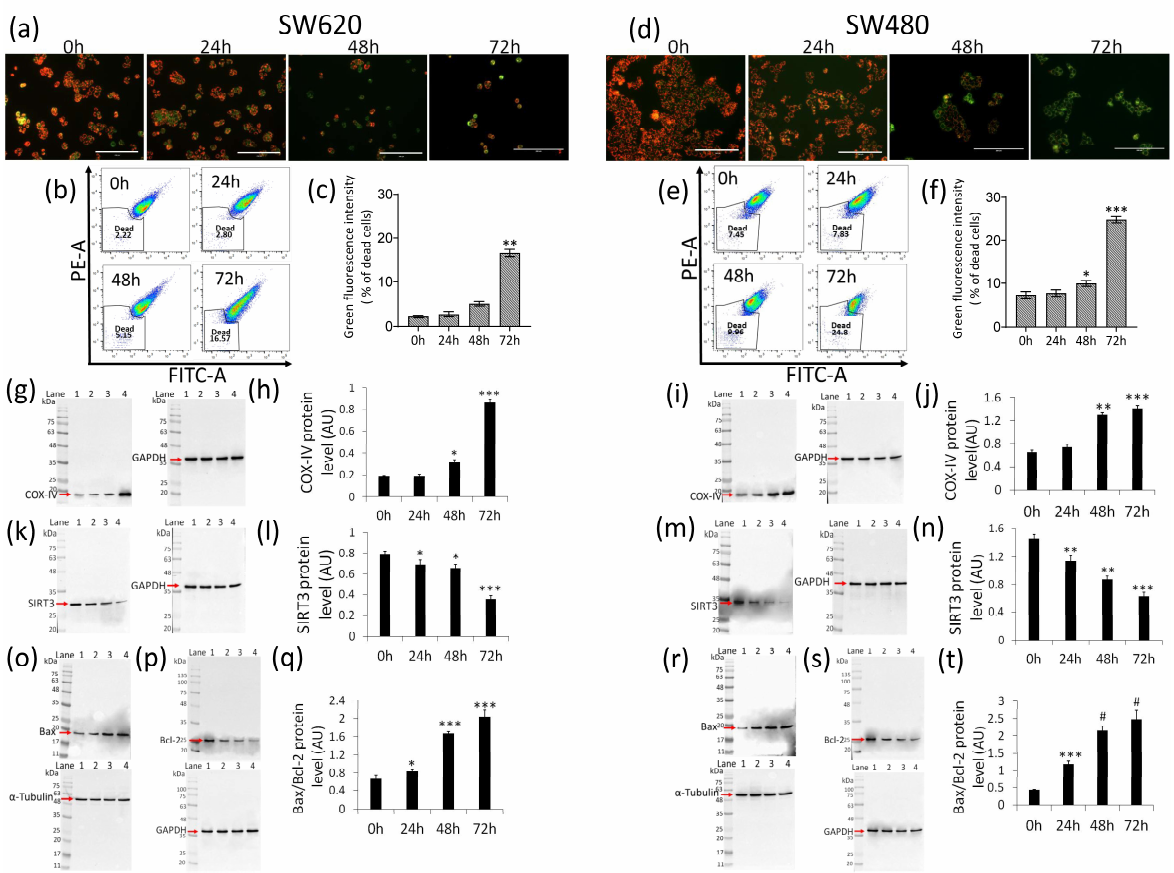
Figure 4. δVB effects on mitochondrial status. Representative images, dot plots and analysis of mitochondrial membrane potential assessed using JC-1 probe, which allows us to detect membrane depolarization through a concomitant decrease in the aggregate signal (red) and accumulation of monomeric species (green), of ( a – c ) SW620 and ( d – f ) SW480 cells. Cells were treated with δVB (1.5 mM) for 24, 48 and 72 h. Results, expressed as green fluorescence intensity, were reported as % of dead cells. Scale bar: 200 μm. Representative immunoblotting images and analyses of ( g – j ) COX-IV, ( k – n ) SIRT3 and ( o – t ) Bax/Bcl-2 protein levels in SW620 and SW480 cells. Lane 1 = 0 h; lane 2 = 24 h; lane 3 = 48 h; lane 4 = 72 h. Before lane 1, molecular weight markers (G266, Applied Biological Materials Inc., Richmond, BC, Canada). Protein expression was calculated, after normalization with internal control (α-tubulin or GAPDH), with ImageJ software and results expressed as arbitrary units (AU). * p < 0.05 vs. Ctr; ** p < 0.01 vs. Ctr; *** p < 0.001 vs. Ctr; # p < 0.0001 vs.